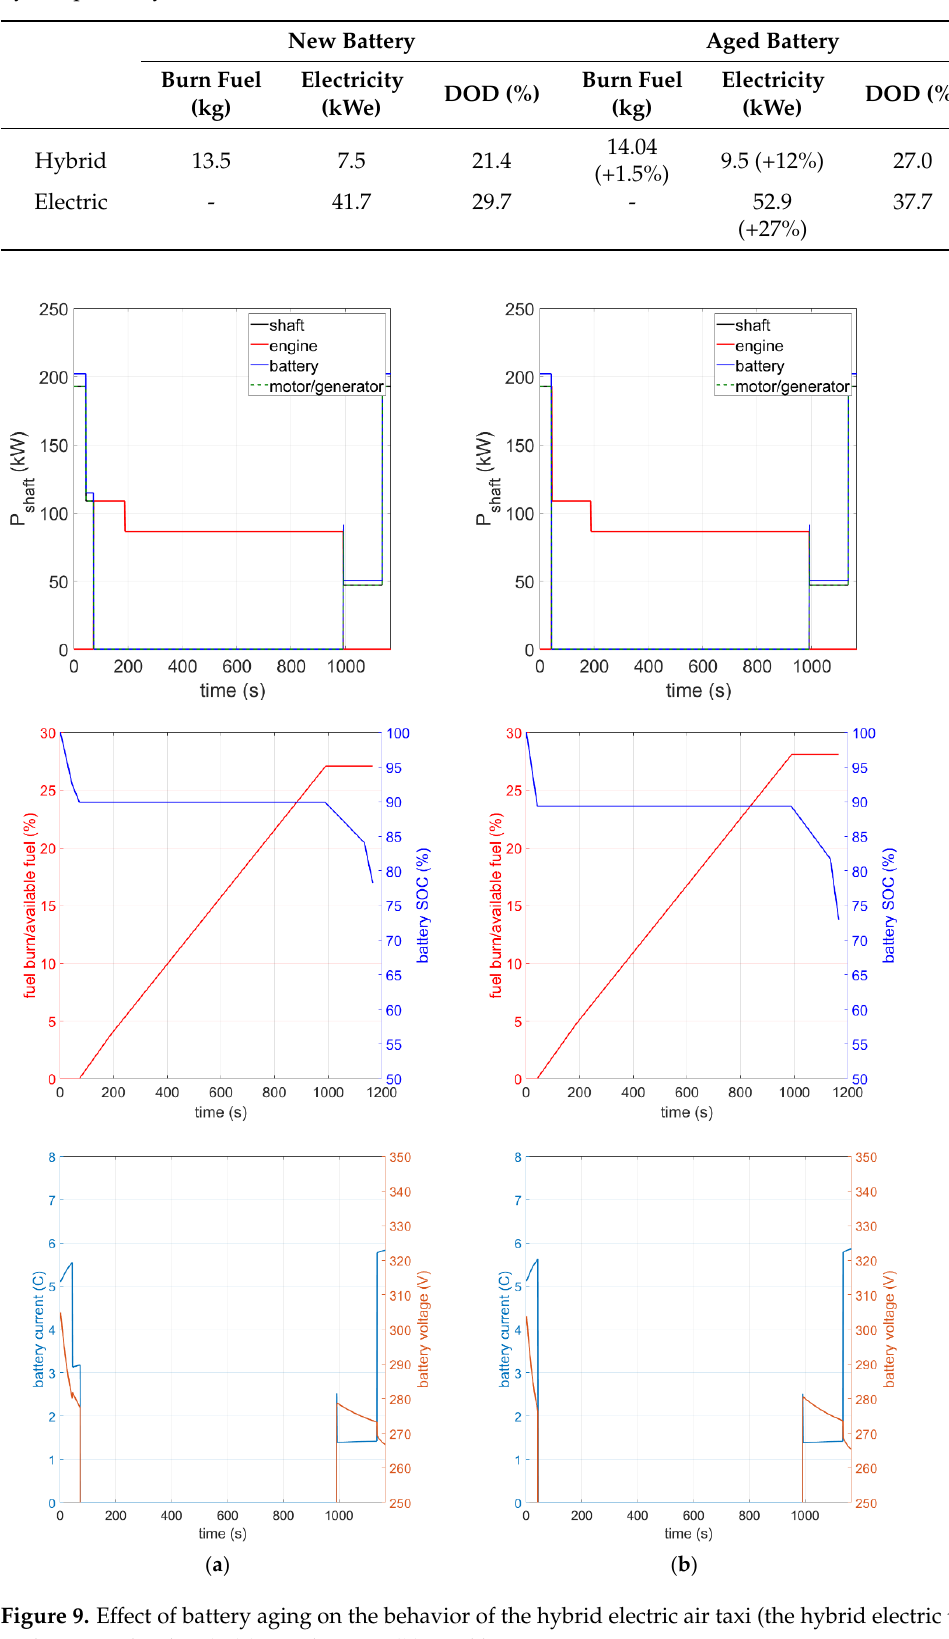
Table 7. Effect of battery aging of consumption (with 2035 technology, rule-based strategy for the hybrid power system).